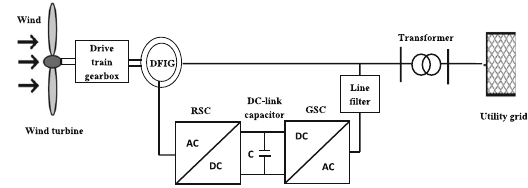
Fig. 1 Schematic diagram of grid tied DFIG wind